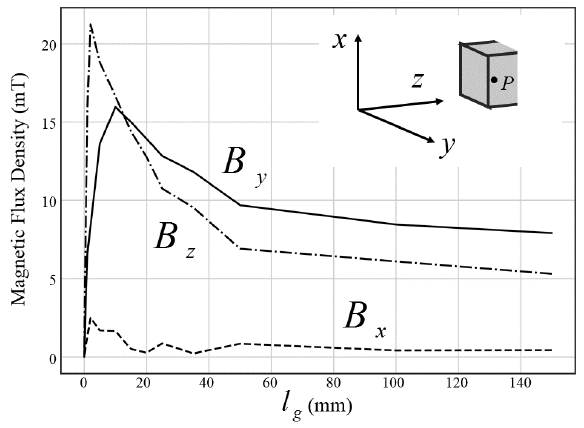
Figure 6. The components of magnetic flux density vector ( B x , B y , B z ) at point P as a function of l g